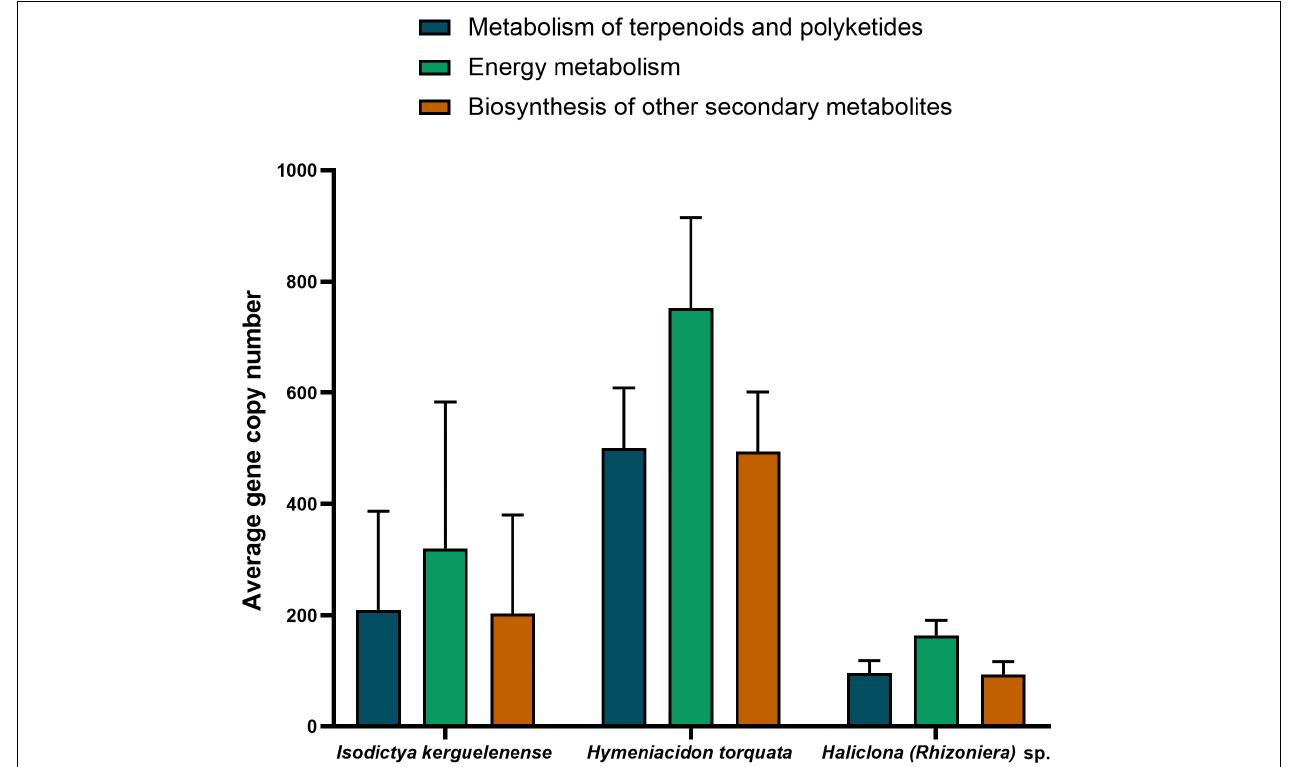
FIGURE 5 | Average gene copy number predicted for each sponge species microbiome for pathways related to energy metabolism, metabolisms of terpenoids and polyketides, and biosynthesis of other secondary